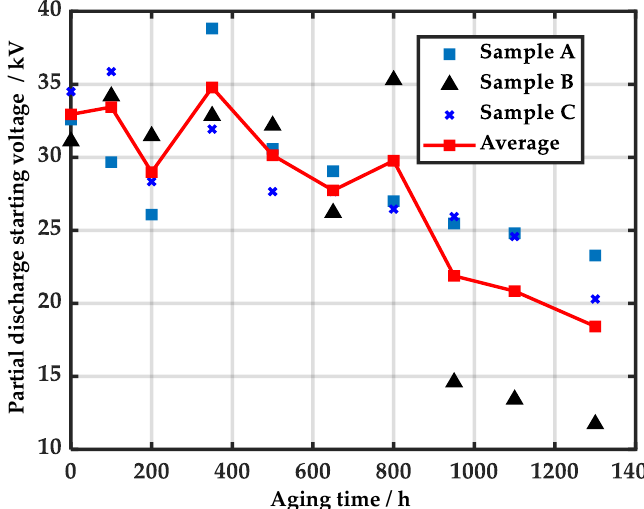
Figure 6. The initial voltage of local discharge under different aging times [31].